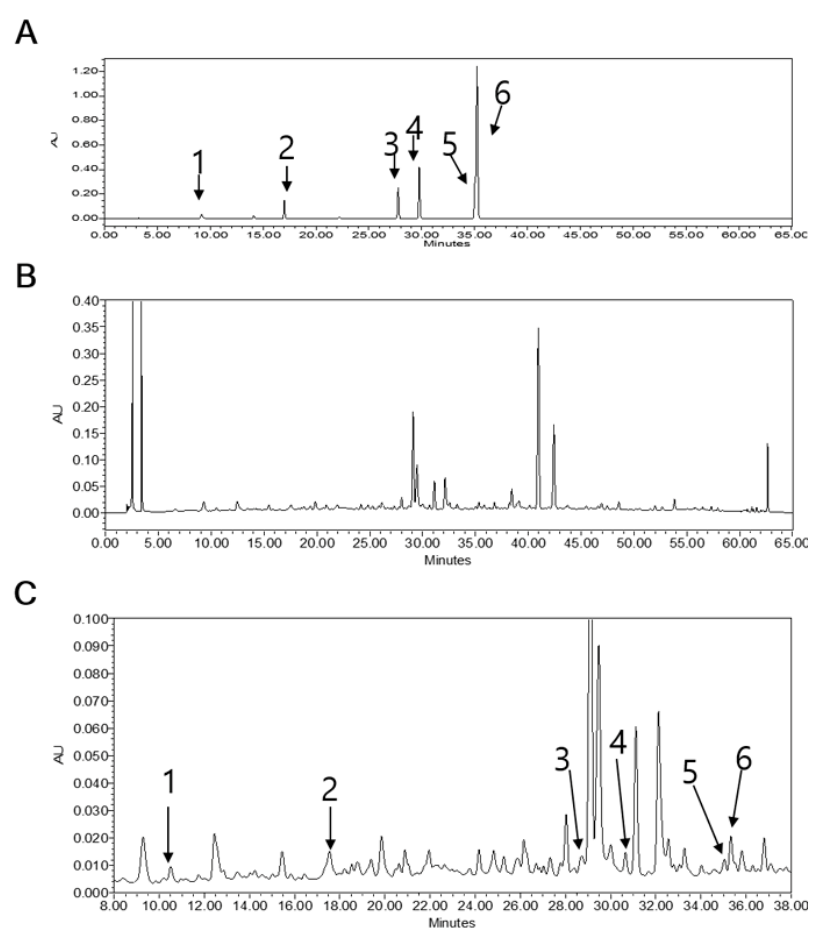
Figure 8. HPLC chromatogram. ( A ) Chromatogram of standard compounds mixtures: ( 1 ) catechin (Rt, 10.18 min), ( 2 ) rutin (Rt, 17.45), ( 3 ) daidzein (Rt, 28.83), ( 4 ) luteolin (Rt, 30.7), ( 5 ) naringenin (Rt, 35.28), ( 6 ) genistein (Rt, 35.32). ( B ) HPLC chromatogram of LB extract. ( C ) Close view of the chromatogram